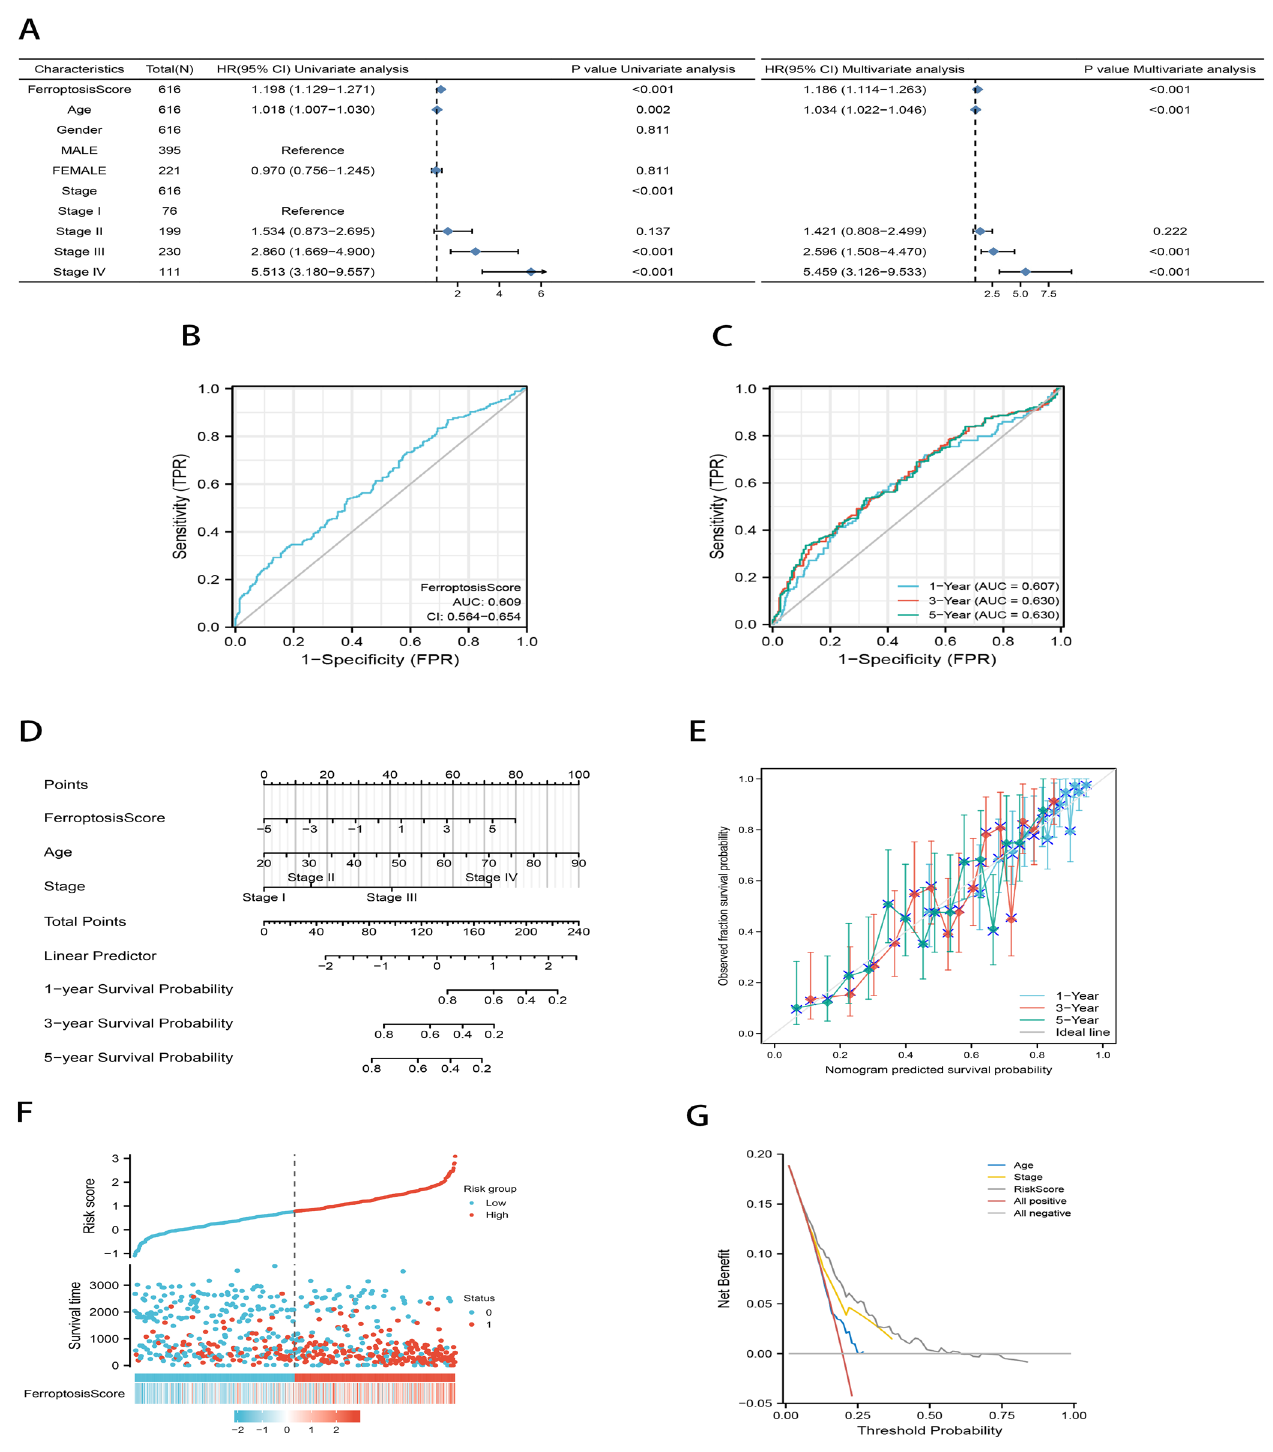
Figure 4. Development of an independent prognostic model for gastric cancer based on ferroptosis. ( A ) Univariate and multivariate Cox analysis of ferroptosis score. ( B , C ) Diagnostic ROC curve ( B ) and time-dependent ROC curve ( C ) for ferroptosis score. AUC: area under the curve. ( D ) A nomogram plot of prognostic multivariate regression model. ( E ) Prognostic calibration plot evaluating the fit analysis of the model to the actual situation. ( F ) Risk factor plot showing the distribution of survival outcomes using the median risk score of the prediction model for grouping patients with gastric cancer. ( G ) Prognostic DCA plot evaluating the clinical utility of the prognostic model.